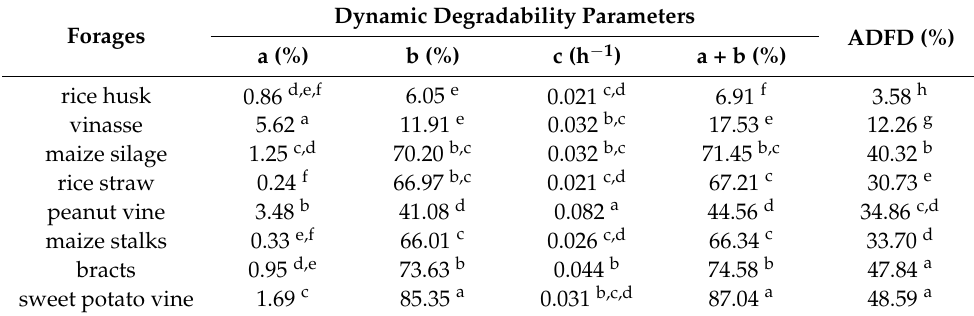
Table 2. The effective degradability of acid detergent fiber (ADFD) in nylon bags of 8 kinds of roughage.